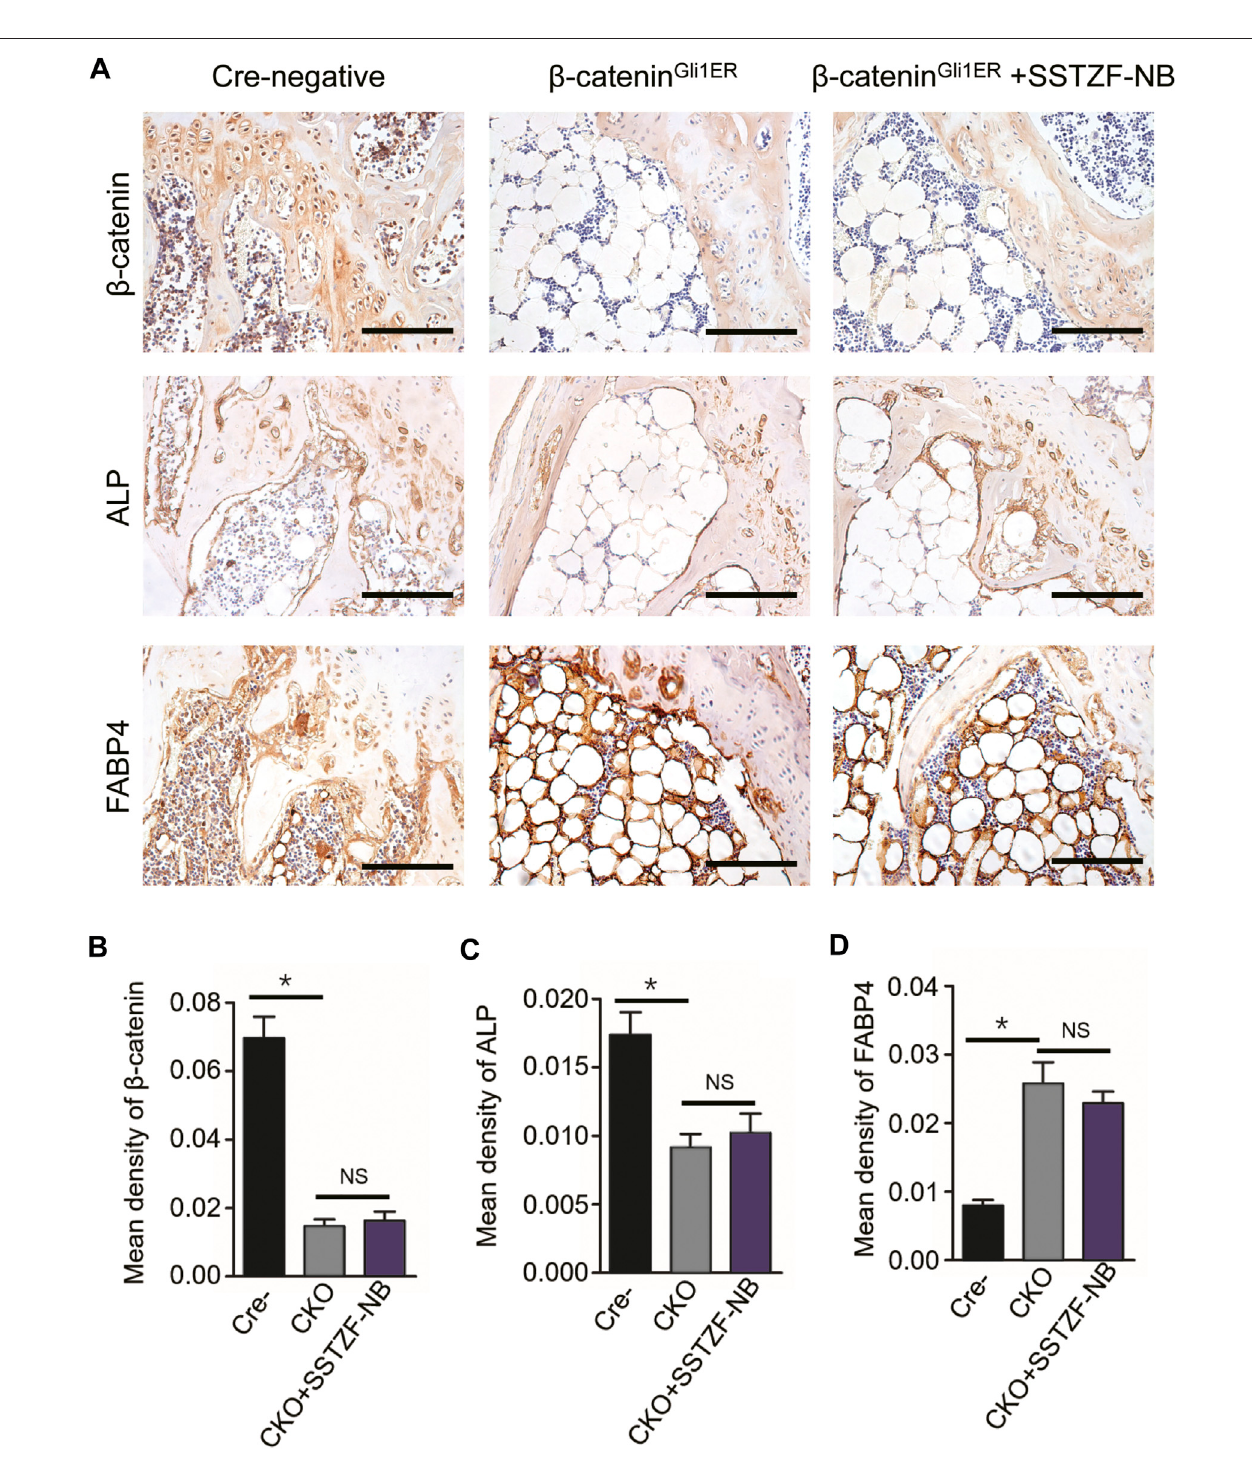
FIGURE 7 | SSTZF-NB failure to restore the down-regulation of ALP and the up-regulation of FABP4 in β -catenin Gli1ER mice. (A) Representative IHC staining imagesof β -cateniningrowthplatechondrocytes,ALP,andFABP4intheareaofchondro-osseousjunction.Scalebars:1,000 μ m.Semi-quantitativeanalysisofpositive expression of β -catenin (B) , ALP (C) and FABP4 (D) . * p < 0.001.